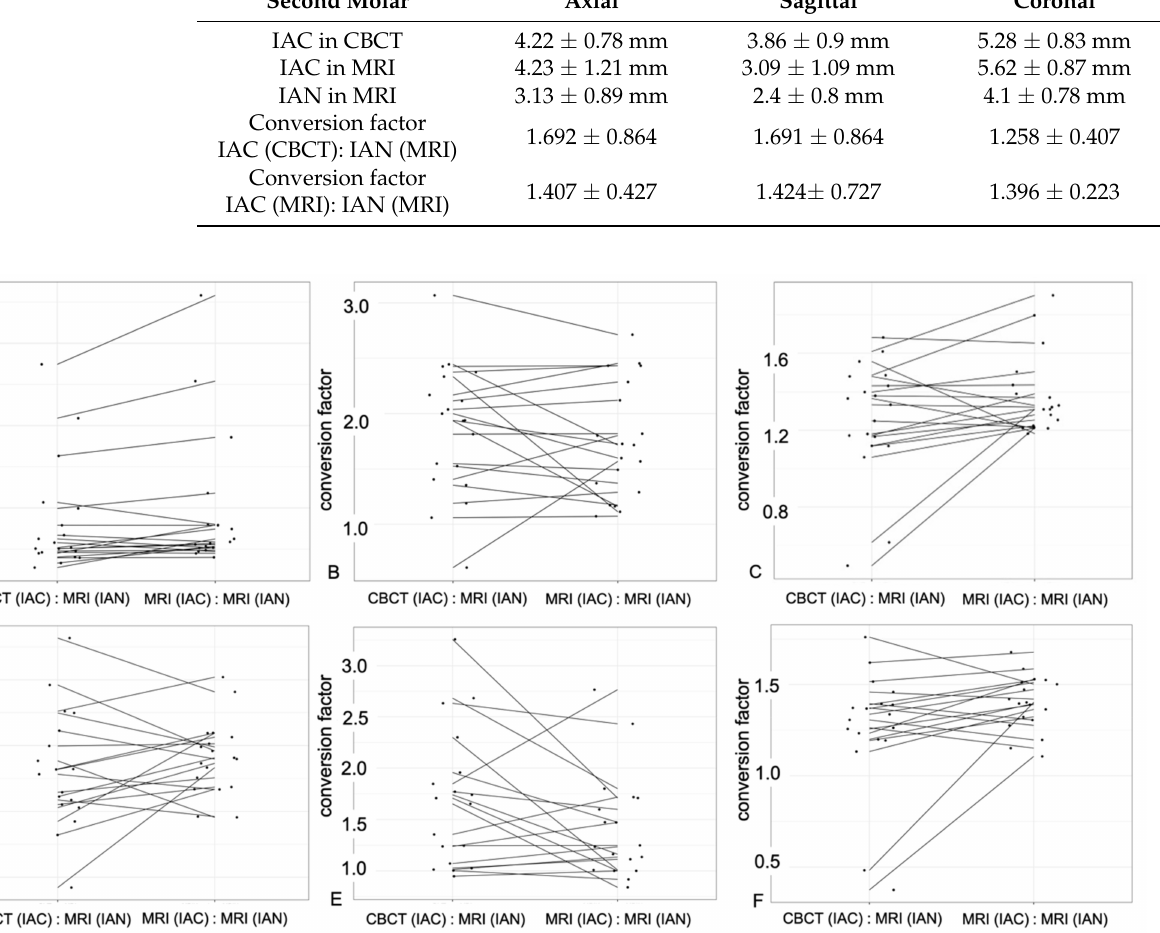
Figure 6. In these six plots, observations for the same subjects are connected by a line to visualize the differences between the two imaging modalities, CBCT and MRI, concerning the conversion factor in the corresponding planes. In the plots ( A–C ) ( A , axial; B , sagittal; C , coronal), the evaluation at the third molar is visualized, and in the plots ( D–F ) ( D , axial; E , sagittal; F , coronal), the evaluation at the level of the second molar is visualized. Thus, this graph visualizes the basis for the statistical inference using the one-sample Wilcoxon signed-rank test, which compares the difference in the two conversion